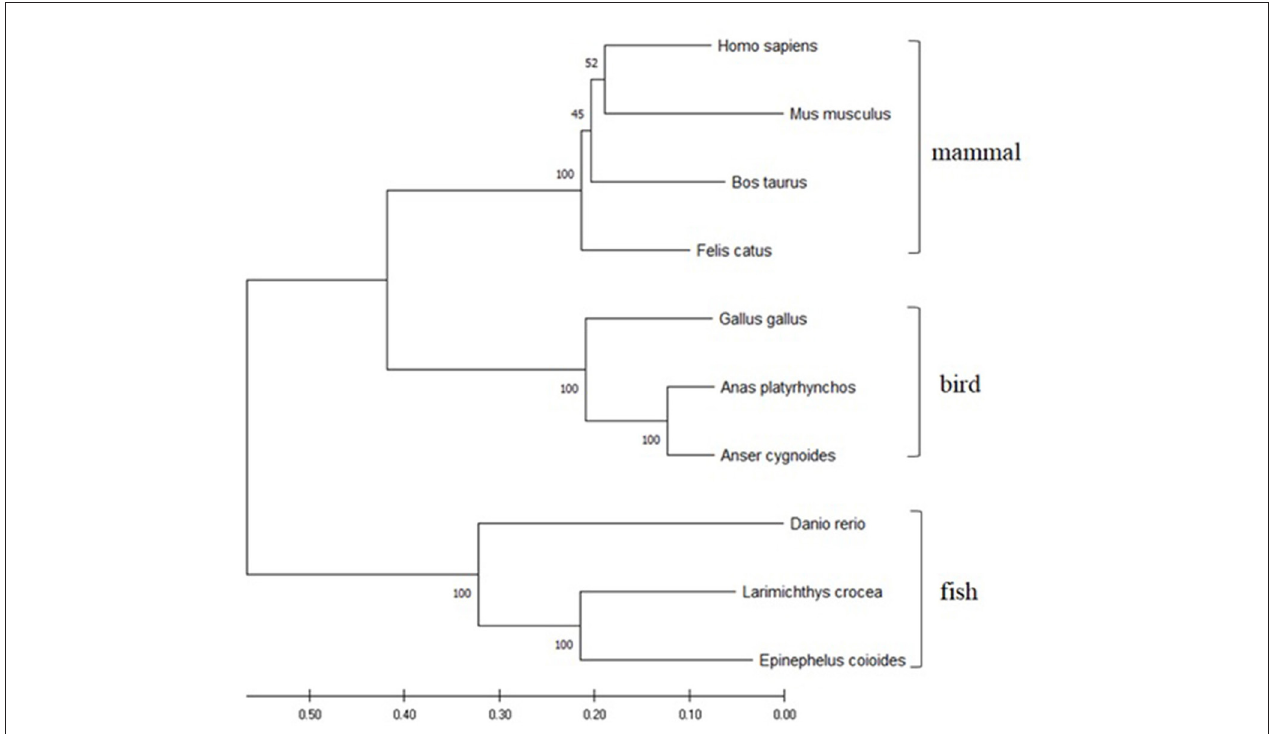
FIGURE 1 | A phylogenetic tree of TRIM25 sequences was generated using MEGA 7.0 and the neighbor-joining method. The sequences were obtained from GenBank: Homo sapiens (NM_005082.5), Mus musculus (NM_009546.2), Danio rerio (NM_200175.1), Gallus gallus (NM_001318458.1), Felis catus (NM_001290251.1), Bos taurus (NM_001100336.1), Larimichthys crocea (MK327541.1), Epinephelus coioides (KX258199.1) and Anser cygnoides (XM_013178947).